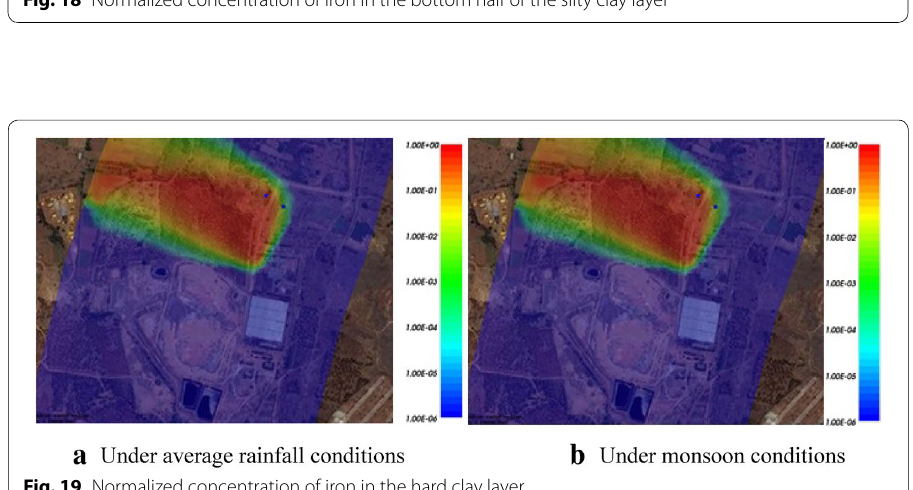
Fig. 19 Normalized concentration of iron in the hard clay